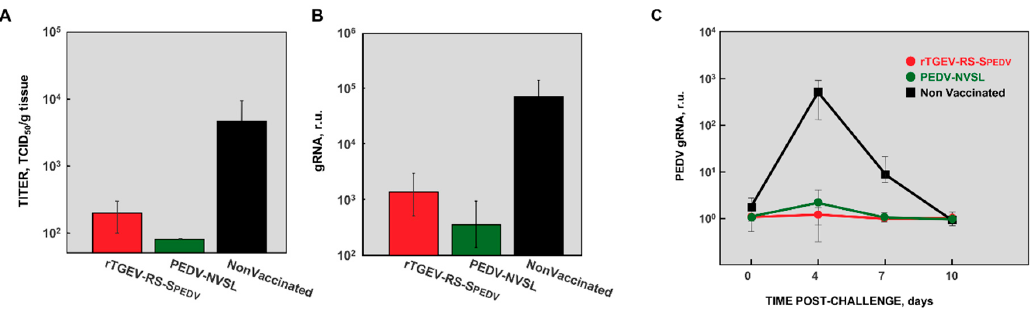
Figure 7. PEDV titers in the enteric tract of animals vaccinated and challenged with virulent PEDV. Four days after the challenge with a virulent PEDV strain, jejunum samples were collected from three piglets per group. Virus presence in these samples was analyzed by titration in Vero cells ( A ) or by RT-qPCR ( B ). In addition, PEDV challenge virus shedding in fecal samples was evaluated at different days after challenge, by RT-qPCR ( C ). Animals vaccinated with rTGEV-RS-SPEDV virus (red); pigs vaccinated with the virulent US PEDV-NVSL strain (green); non-vaccinated and challenged animals (black). Error bars represent the standard deviation for each value.